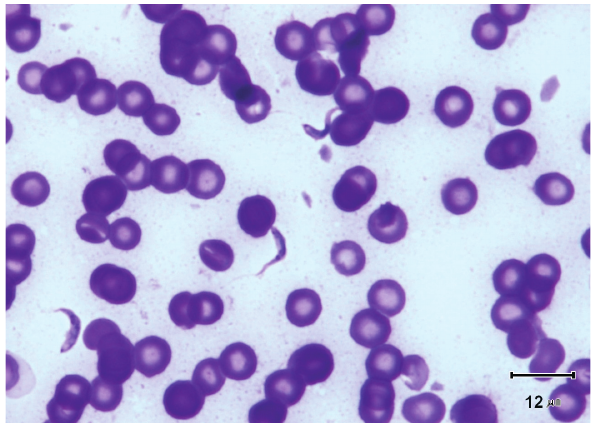
leaf.Fig. 5. – Typical T. (Nannomonas) isomorph ( congolense -forms) without a free flagellum. Photo by Marc